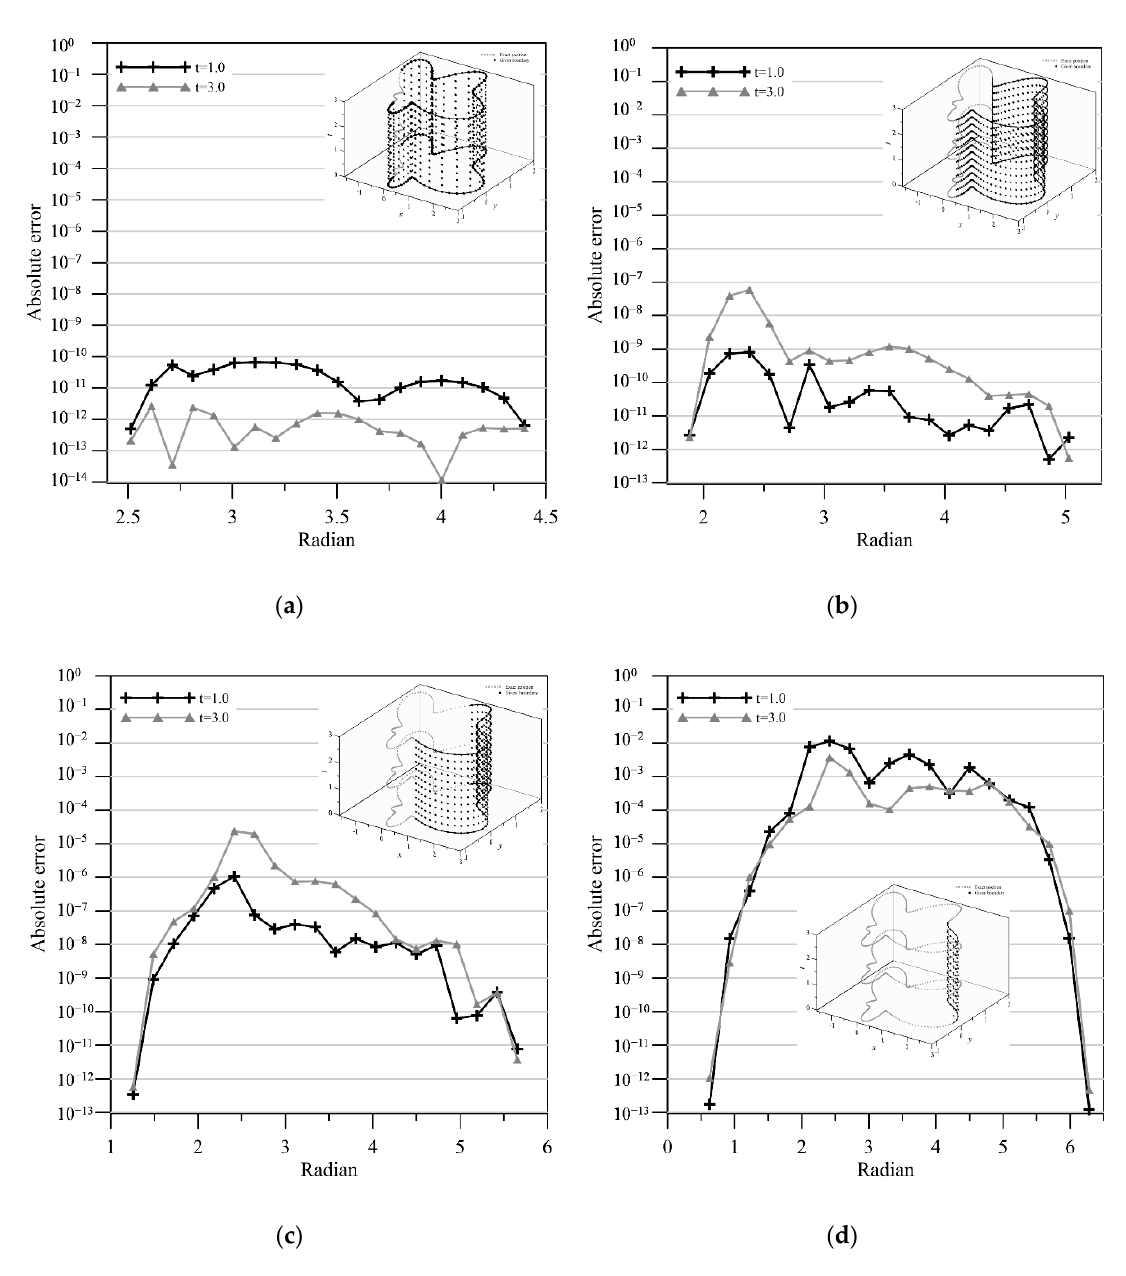
Figure 8. Absolute error of the results at different times: ( a ) case A; ( b ) case B; ( c ) case C; ( d ) case D. Table 2. Error of the proposed approach for case A.